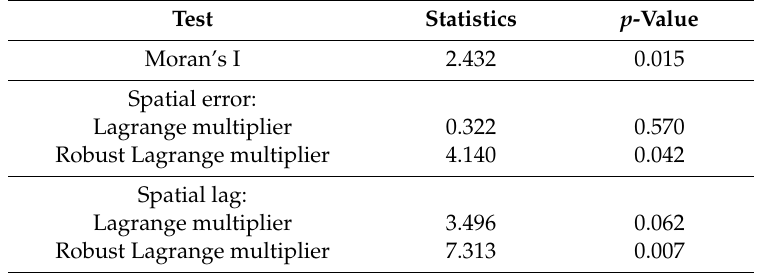
Table 6. Diagnostic tests for spatial dependence in OLS regression; Source: own calculations.